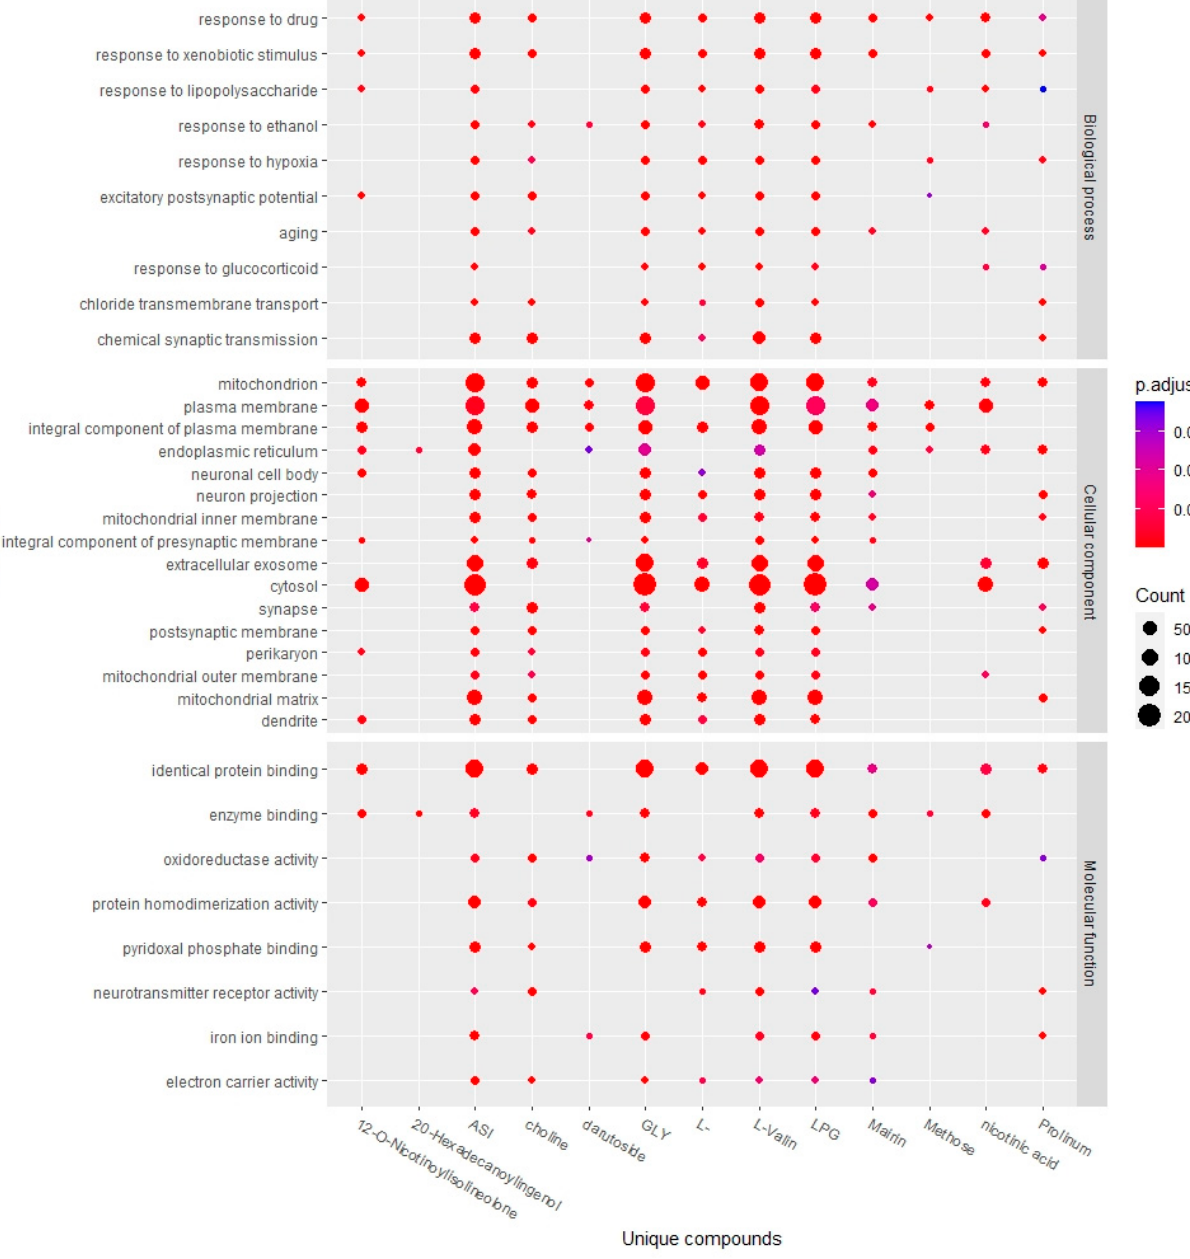
Figure 4. Top main GO terms of unique compounds of Qi-invigorating herbs. LPG, L-alanine; GLY, glycine; ASI, aspartic acid; L-, L-arginine.